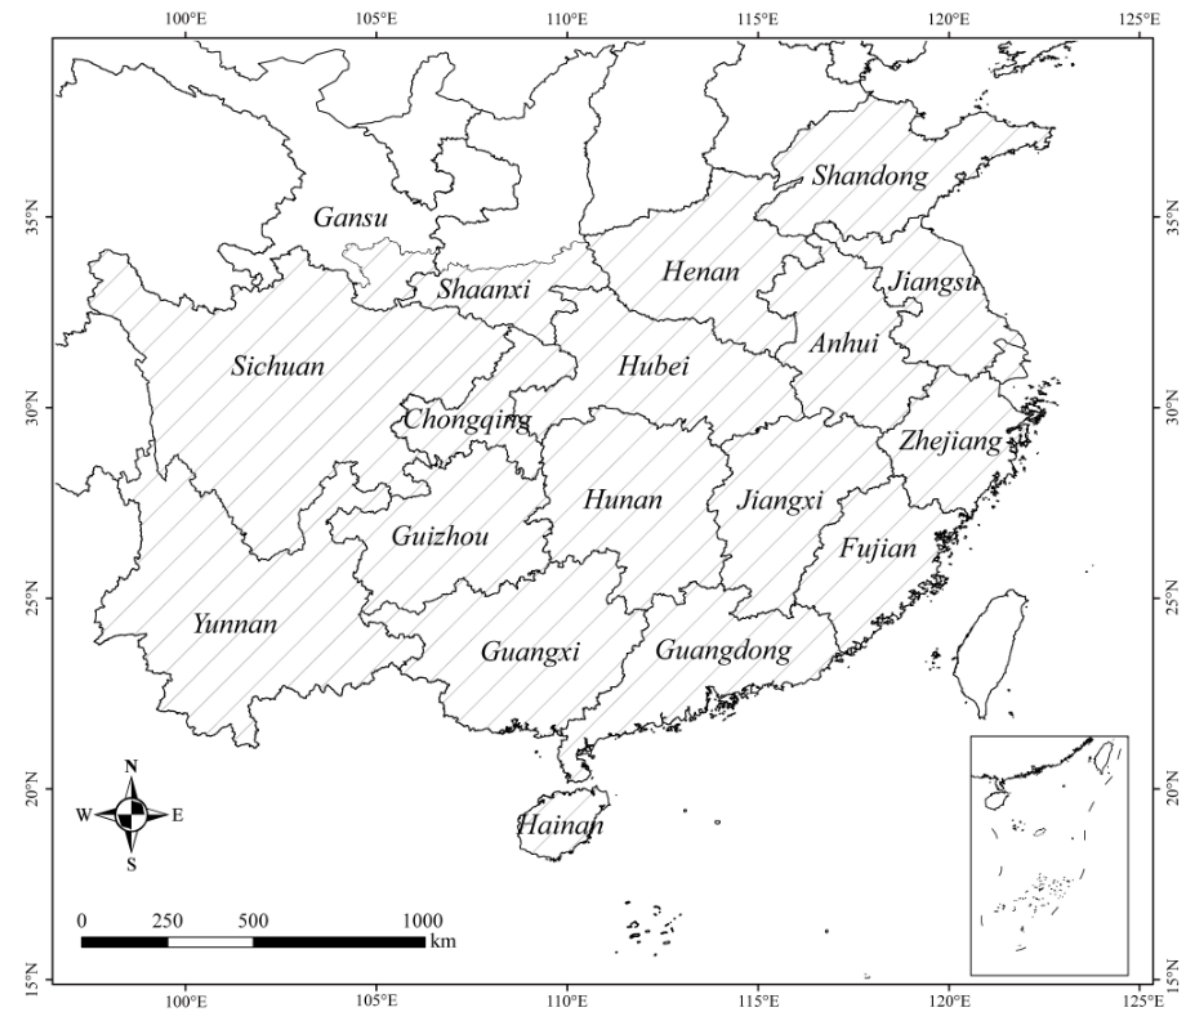
Figure 2. Study area of Chinese mainland (shaded). The correspondence of provinces and national tea regionalization scheme: North Yangtze River Region, including Shandong and Henan provinces, as well as parts of Shaanxi and Gansu provinces; South Yangtze River Region, including six provinces of Hunan, Jiangxi, Zhejiang, Jiangsu, Anhui, and Hubei; Southern China Region, including four provinces of Guangdong, Guangxi, Fujian, and Hainan; Southwest China Region, including three provinces of Guizhou, Sichuan (Chongqing), and Yunnan.